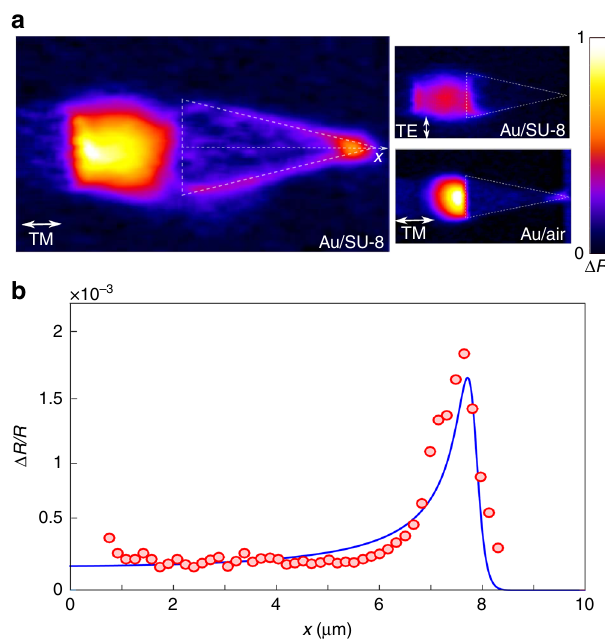
Fig. 3 SPP damping rate enhancement at the tip apex. a Δ R image recorded for Δ t = 1 ps corresponding to a maximum signal at the taper apex. The superimposed thin-dashed lines show the taper contours. Uppermost inset: Δ R image recorded for a pump-beam polarized parallel to the slits. Lowermost inset: Δ R image recorded for TM polarization with a probe beam incident from air and focused on the air/Au interface. The Δ R images are 16 × 7 μ m 2 large and are displayed with the same color scale. b Lineshape of the normalized re fl ectance variation Δ R ( x )/ R ( x ) recorded along the taper longitudinal x